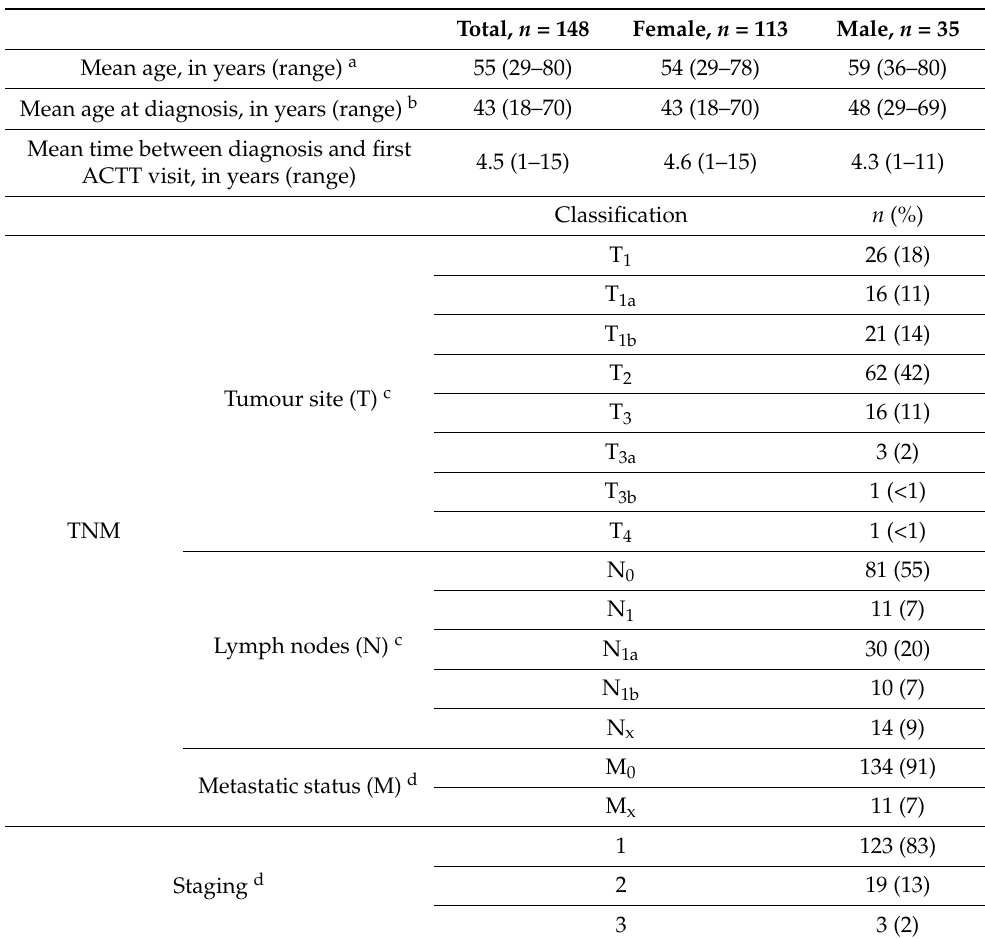
Table 1. Clinical characteristics of diagnosis for thyroid cancer patients in After Cancer Treatment Transition (ACTT) clinic.